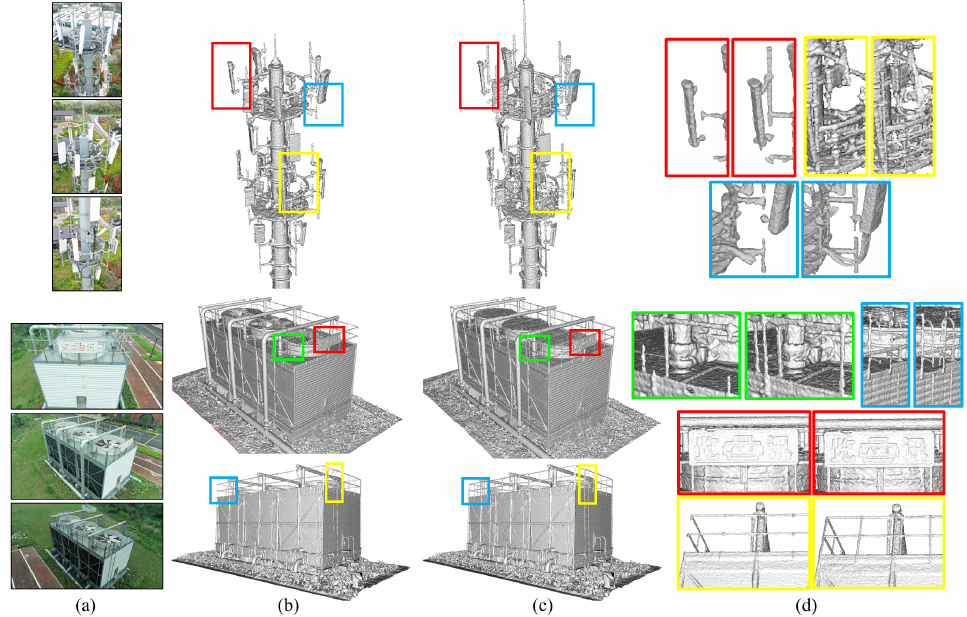
Figure 6. ( a ) Three representative image views for each case of “B5 Tower” and “ZJU Fan”. ( b ) The reconstructed surface models of the two cases by [58]. ( c ) The surface models generated by our meshing approach. ( d ) Comparisons of the details in the rectangles of ( b , c ), which shows the effectiveness of our detail-aware surface